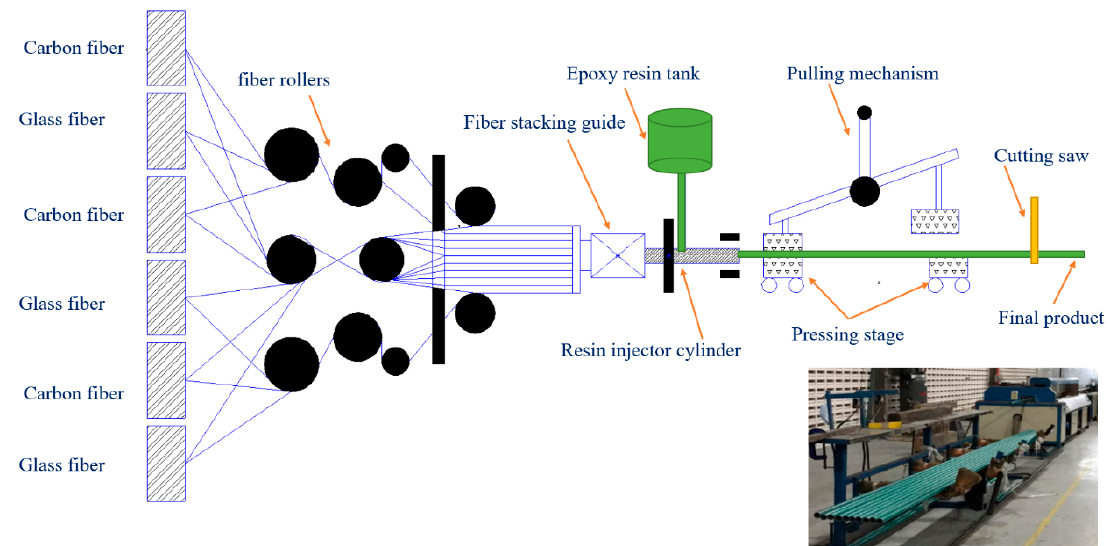
Figure 1. Schematic view of pultrusion processing method.